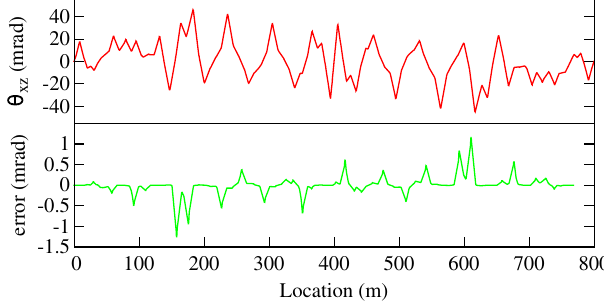
FIG. 3. Top: θ xz crabbing angle calculated using Eq. (38). Bottom: difference between θ xz obtained from Eq. (38) and the actual tilt of the beam